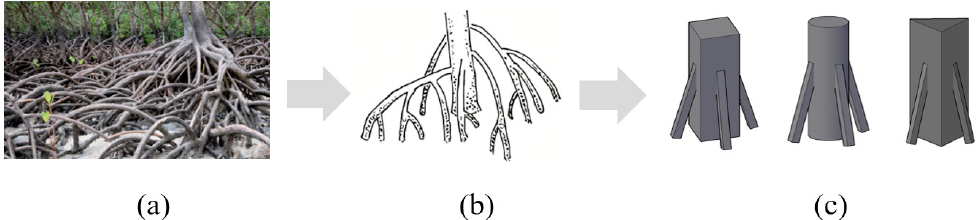
Figure 10. The extraction and transformation of root characteristics of mangrove plants, ( a ) mangrove root system, ( b ) linear diagram of root morphology and structure, and ( c ) geometric structure condensation.